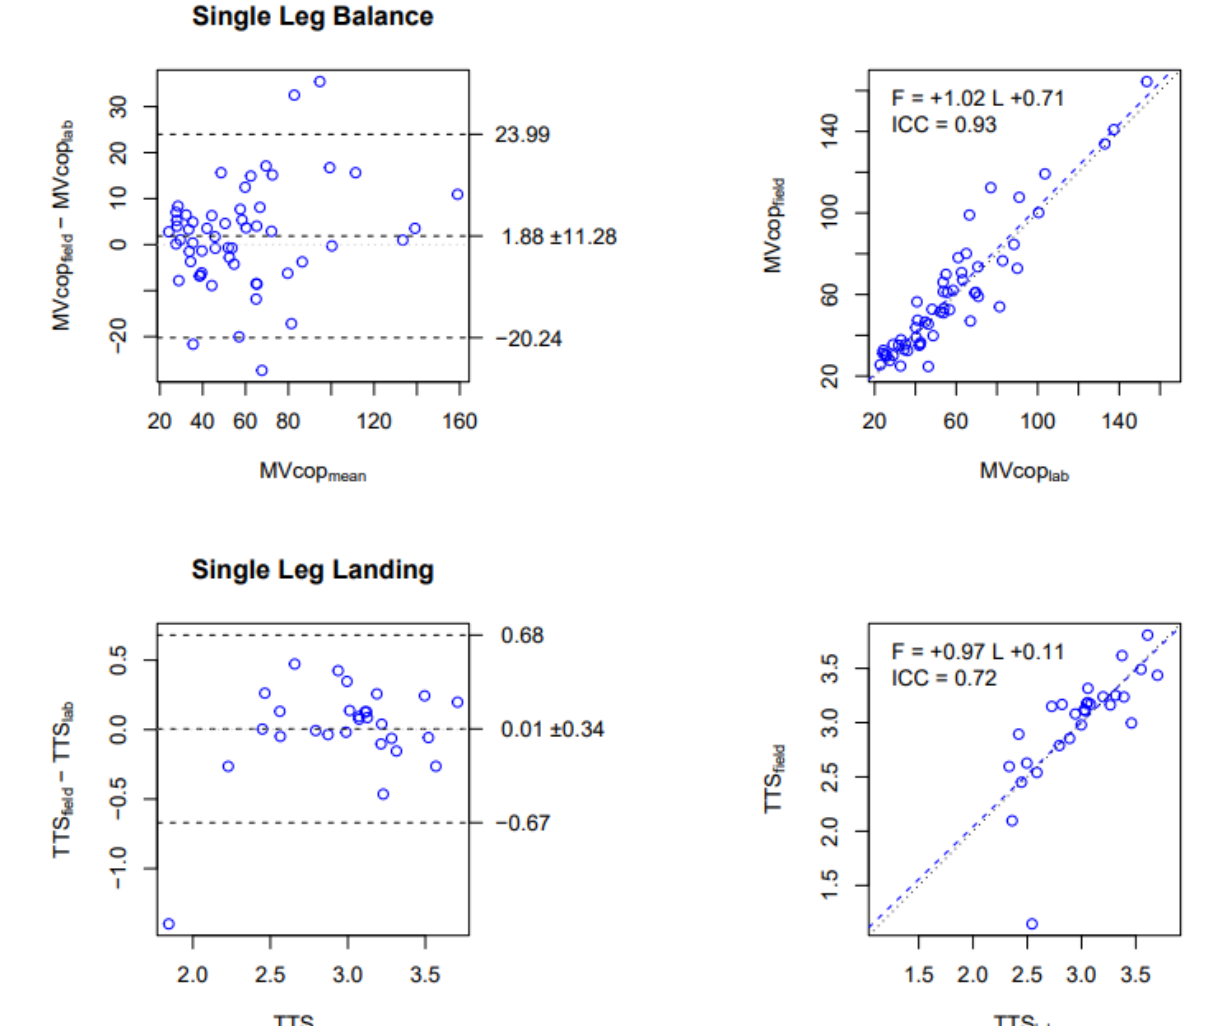
Figure 3. Comparison of MVcop and TTS obtained in the Laboratory vs. in the Field with the PLATES. Upper row: MVcop for the Single Leg Balance test (mm/s). Lower row: TTS for the Single Leg Landing test (s). Left column: Bland and Altman plot. The central horizontal line indicates the mean of the differences (systematic bias), which is 0 for perfect agreement. The horizontal lines above and below represent the 95% limits of agreement. Right column: Linear regression. Data from all conditions are reported (i.e., 14 participants × 4 conditions for SLB, 14 participants × 2 conditions for SLL). Each dot corresponds to the average over the 3 repetitions in each condition. The figures show that MVcop and TTS are strongly correlated between PLATES in laboratory and field settings.